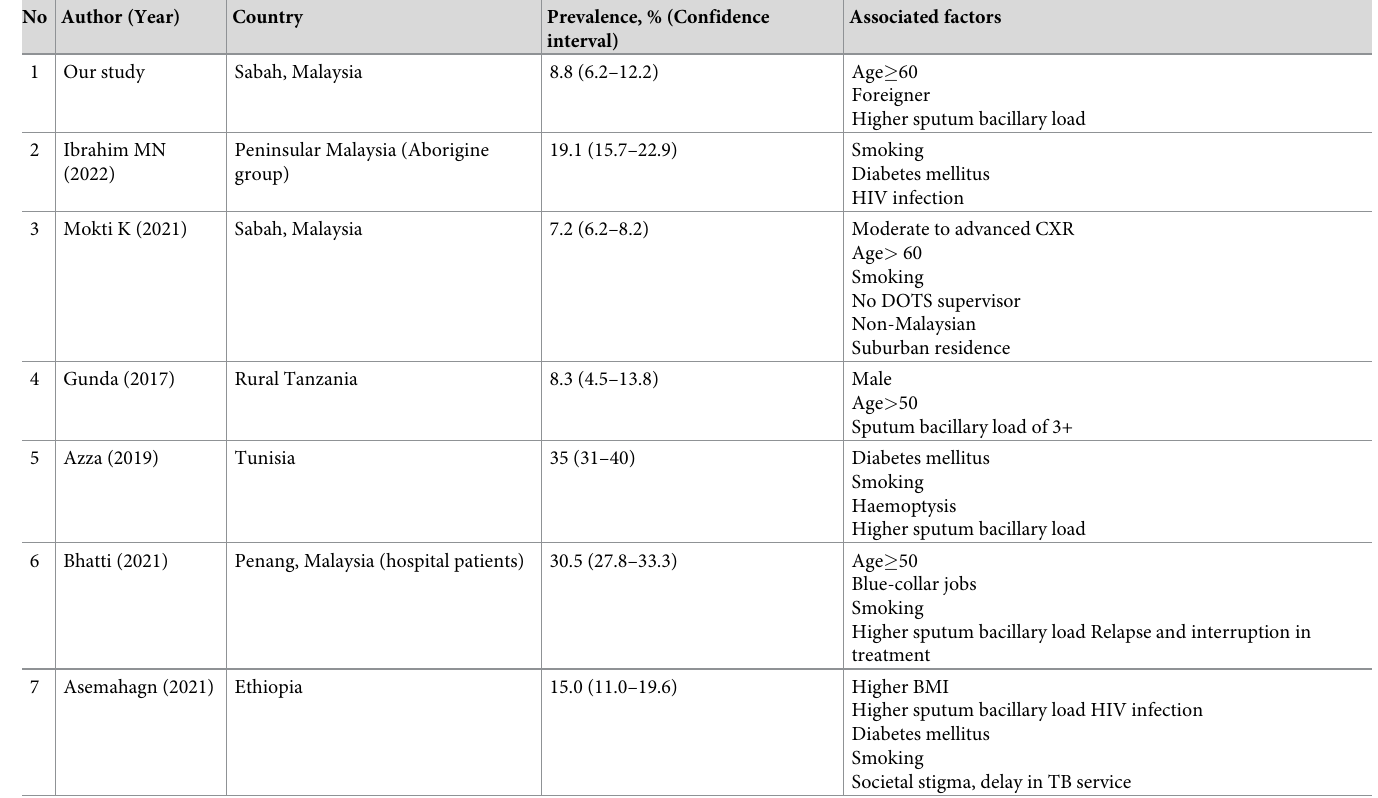
Table 4. Comparison of prevalence of delayed sputum conversion and its associated factors in recent studies (year